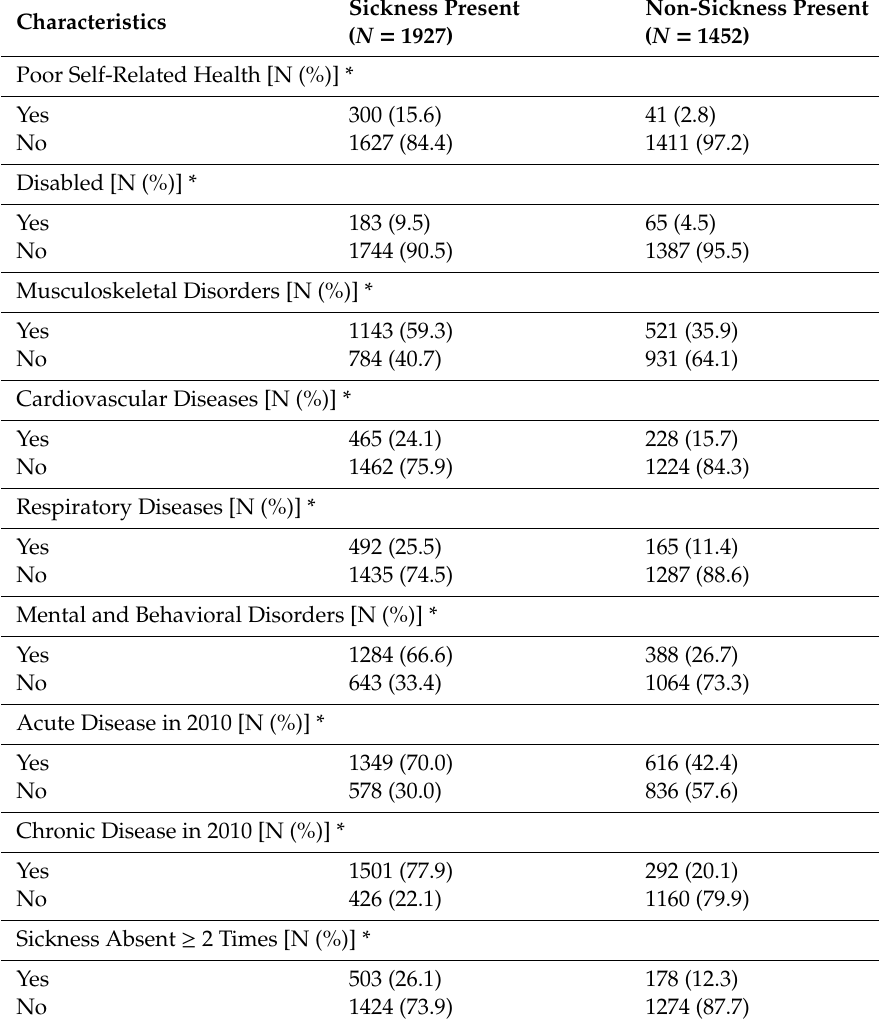
Table 3. Health status and work ability of the study